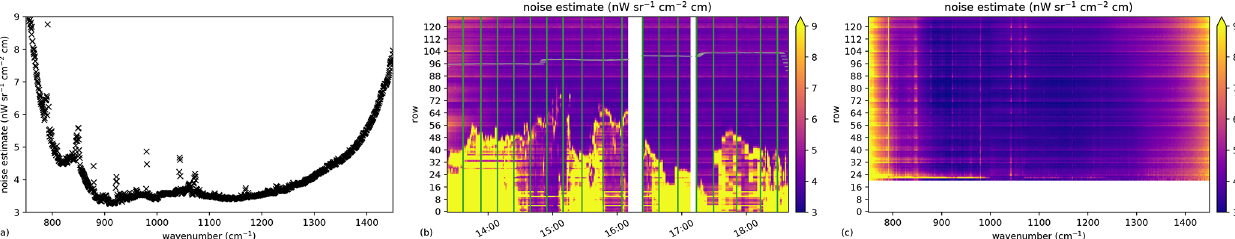
Figure 17. Example of the NESR analysis of atmospheric spectra for the WISE flight of 15 October 2017. Panel (a) shows a single NESR spectrum averaged over time and pixels. Panel (b) shows the spectrally averaged NESR. Panel (c) shows the NESR averaged over time.